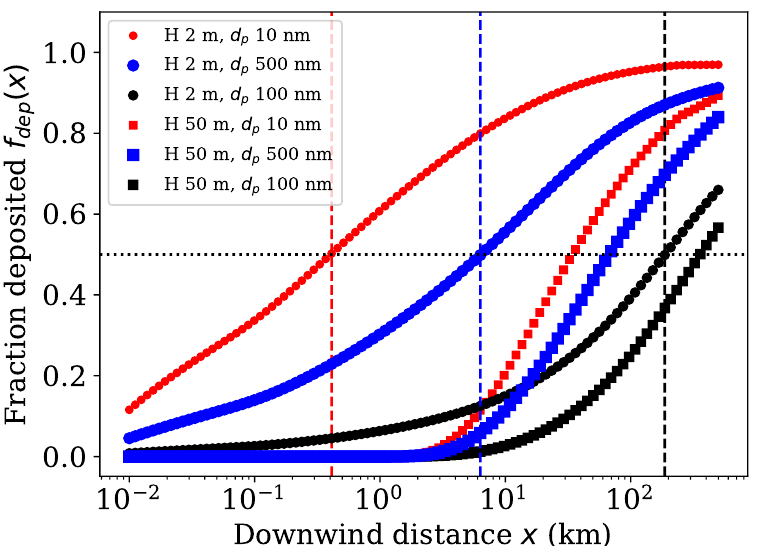
Figure 2. Fraction of ENM deposited to the ground for different particle sizes d p and source heights H . Vertical dashed lines represent the distances of 50% deposited, that is x 50